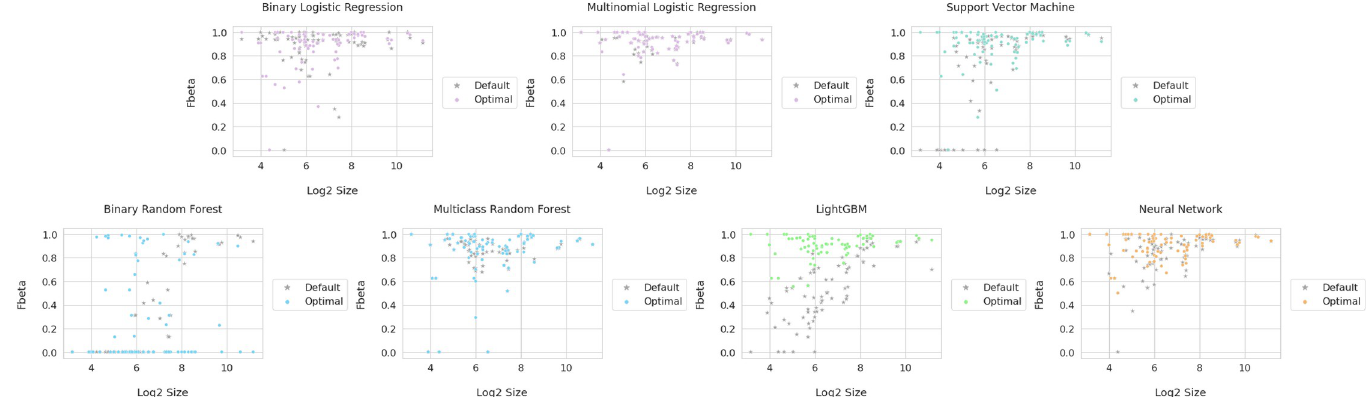
Fig 3. Classification performance between the default and optimal hyperparameter settings. The 3.5 CV feature set was used and models produced using default and optimal hyperparameter setting. F-beta was calculated as a measure of classification accuracy. Log2 size is log base 2 of the cluster size. The labeled p-values for each method are from the Wilcoxon signed-rank test between the default and optimal